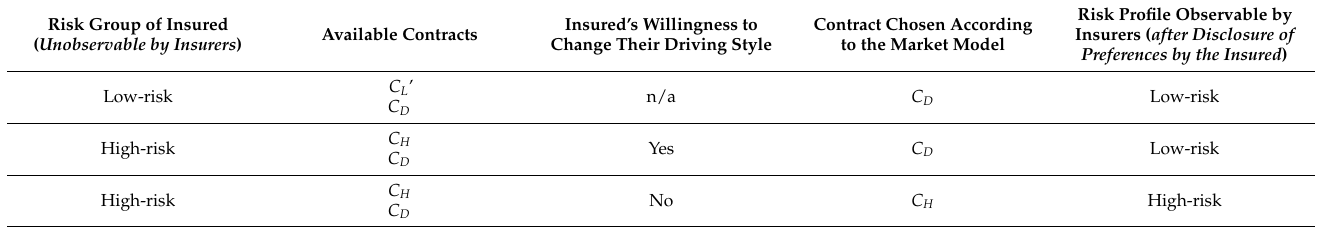
Table 3. Risk profiles that can be observed by the insurer after the insured person chooses the type of